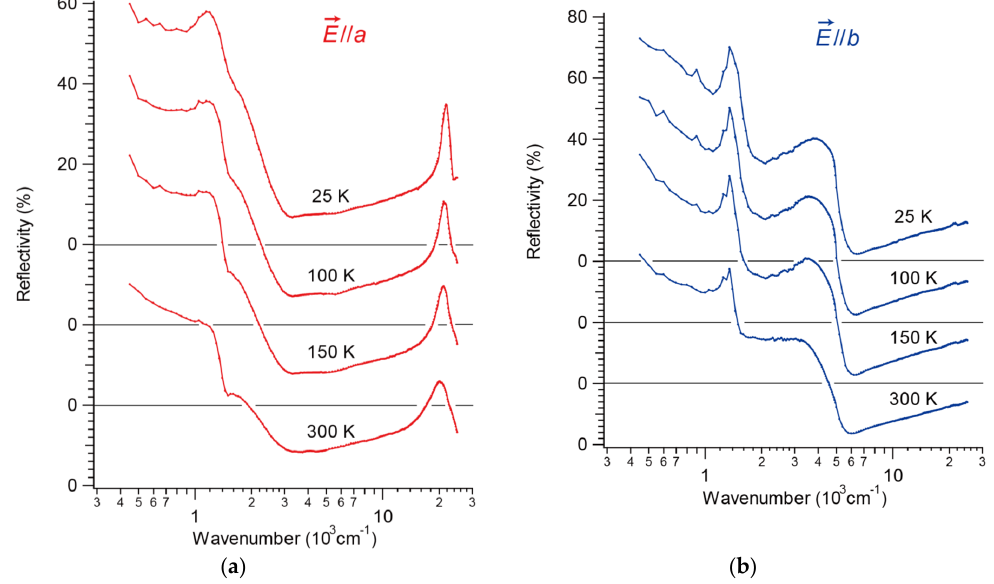
Figure 6. Temperature-dependent reflectance spectra of α -STF 2 I 3 . The spectra measured with setting the polarization, i.e., the alignment of electric field ( E -vector) in the incident light along the crystallographic: ( a ) a -axis; ( b ) b -axis. Note that each spectrum at 150, 100 and 25 K is offset by 20%, 40% and 60%, respectively in Figure 6a,b.